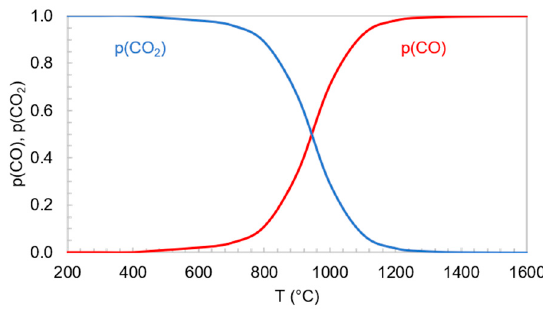
Figure 1. Temperature-dependent equilibrium of the Boudouard reaction.